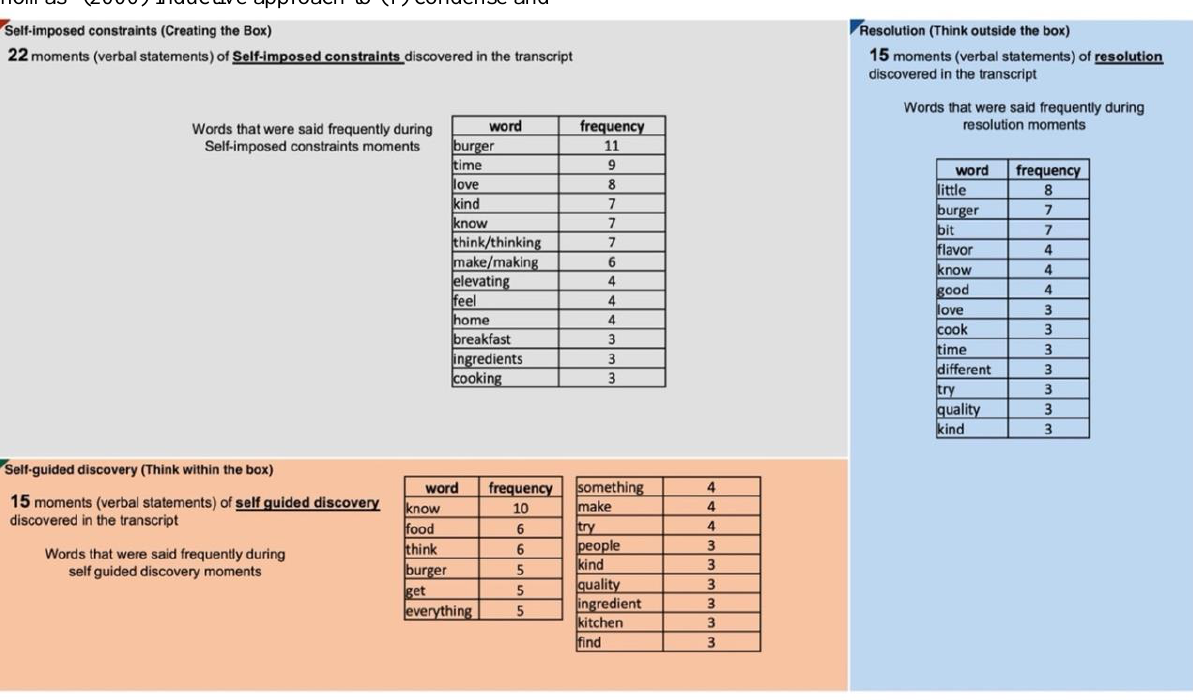
Fig. 2 . Treemap with frequent keywords. The size of each box is proportional to the number of moments coded for each theme. Words that were said frequently were then extrapolated from the data using